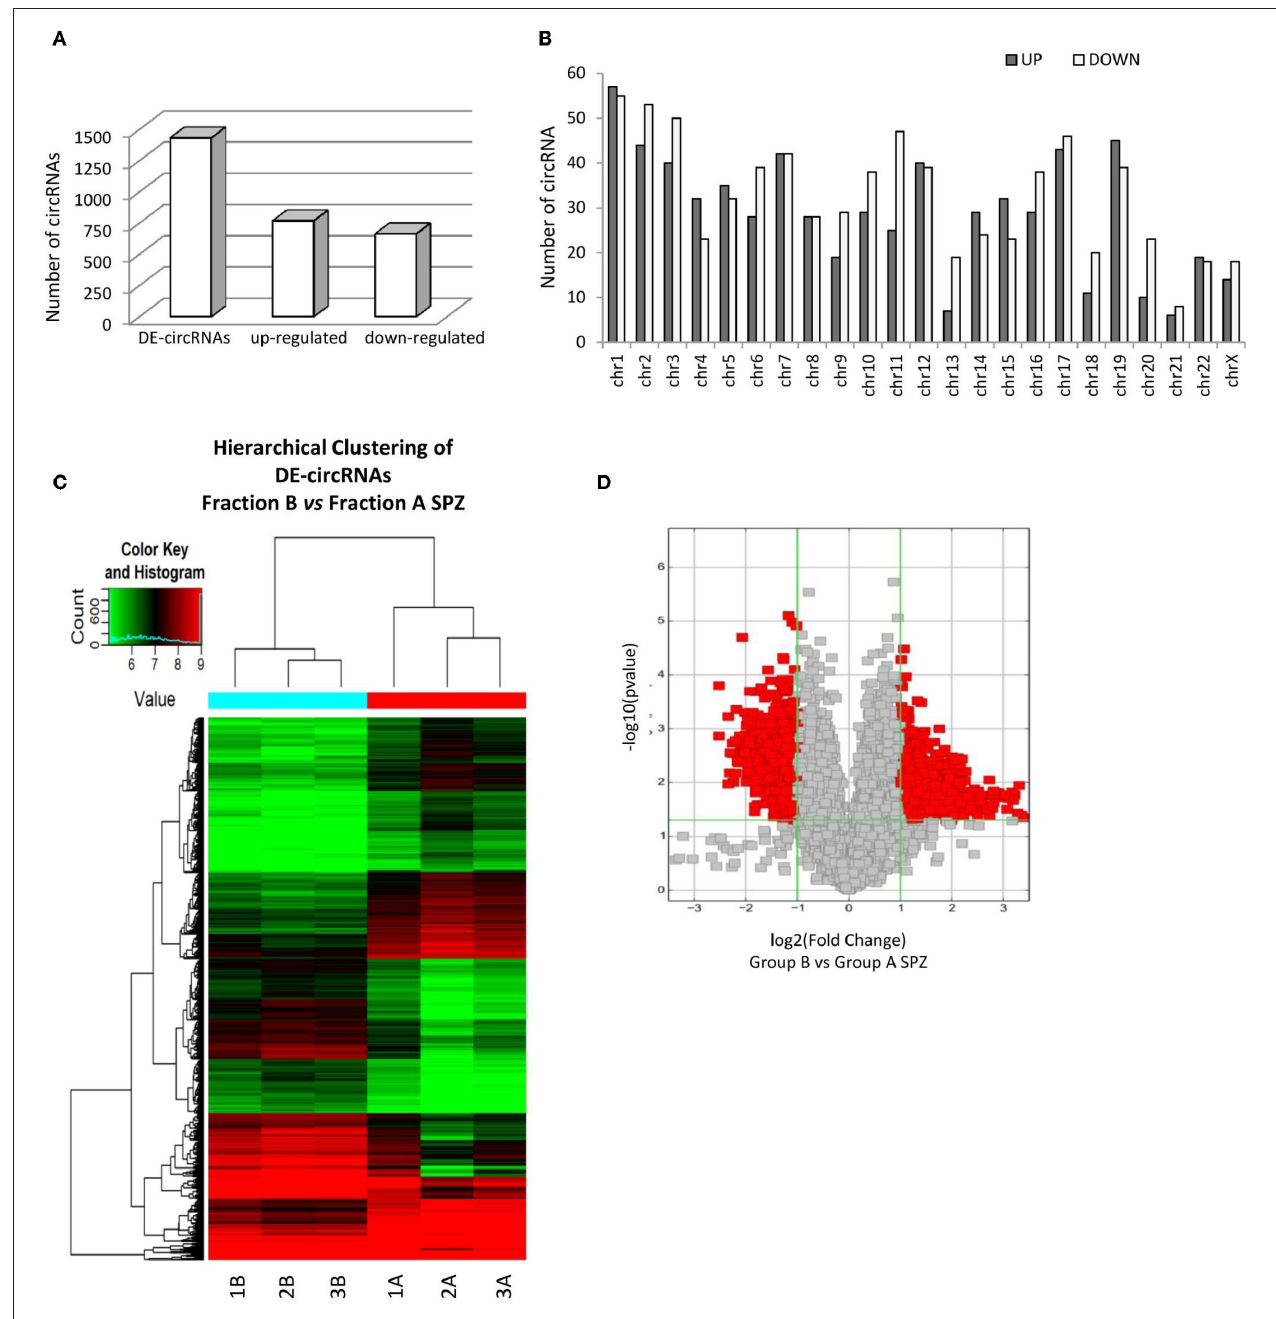
FIGURE 2 | Differential expression of circRNAs between fraction A and B asthenozoospermic derived SPZ. Differential expression of circRNAs between fraction A and B SPZ. (A) The distribution of up- and down-regulated DE-circRNAs in fraction B compared to fraction A SPZ. (B) The distribution of up- and down-regulated DE-circRNAs in the human genome, according to their host gene location. (C) Hierarchical clustering analysis of DE-circRNAs in A SPZ (samples 1A, 2A, 3A) and B SPZ (samples 1B, 2B, 3B). The expression values (Fold change ≥ 1.5, p ≤ 0.05) are represented in different colors, indicating expression levels above and below the median expression level across all samples. (D) The volcano plot was constructed using Fold-Change and p -values; in detail, the values on X and Y axes are log2 (FC = Fold-Change) and –log10 ( p -values), respectively. Red points in the volcano plot represent the DE-circRNAs with statistical